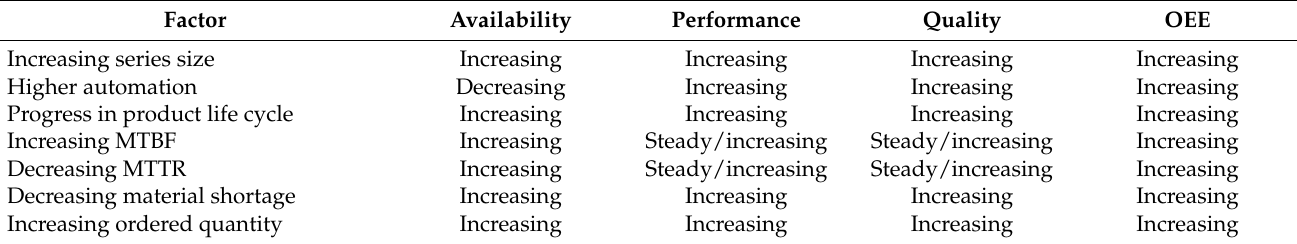
Table 1. Factors of production environment.